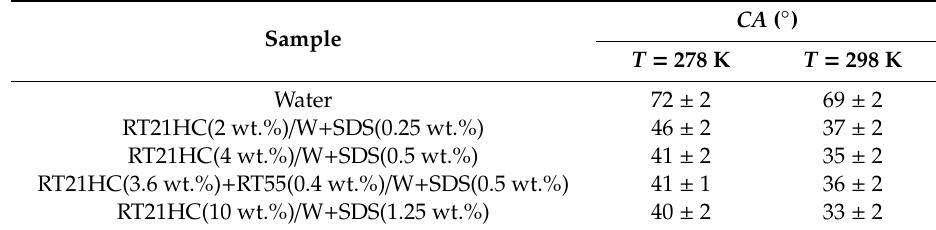
Figure 7. Examples of sessile drops analyzed at 278 K for: ( a ) water; ( b ) RT21HC(2 wt.%)/Water; ( c ) RT21HC(4 wt.%)/Water and ( d ) RT21HC(10 wt.%)/Water. Table 3. Contact angles, CA , measured for distilled water and studied nano–emulsions on a stainless steel substrate [36]. Relative humidity: 50 ± 10%.